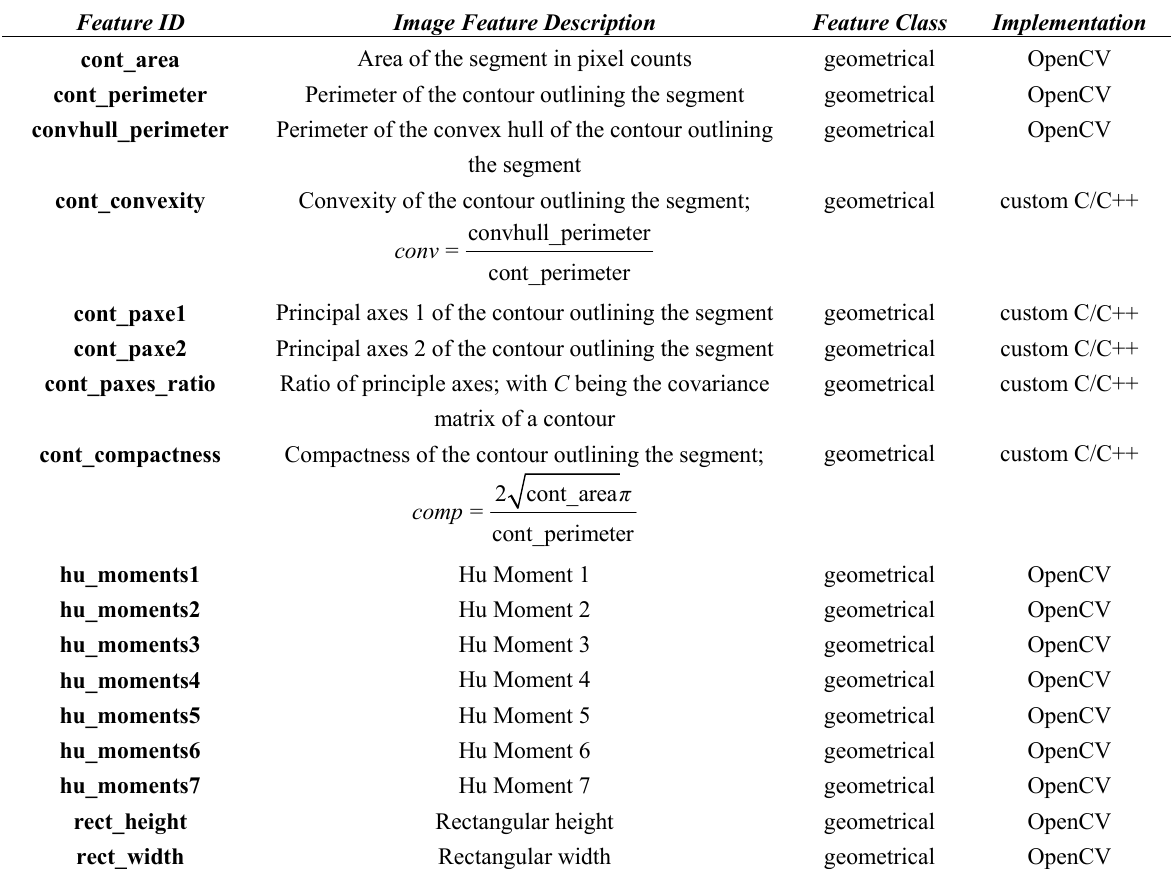
Table 3. List of image features (part II of II). All image features are computed per